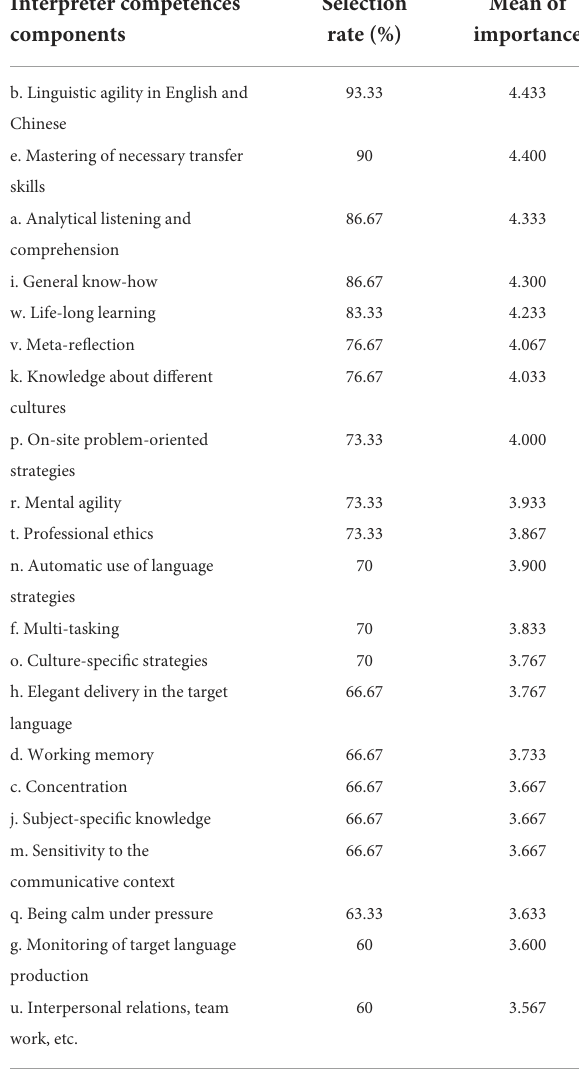
TABLE 9 Frequently selected components which contributed to development of